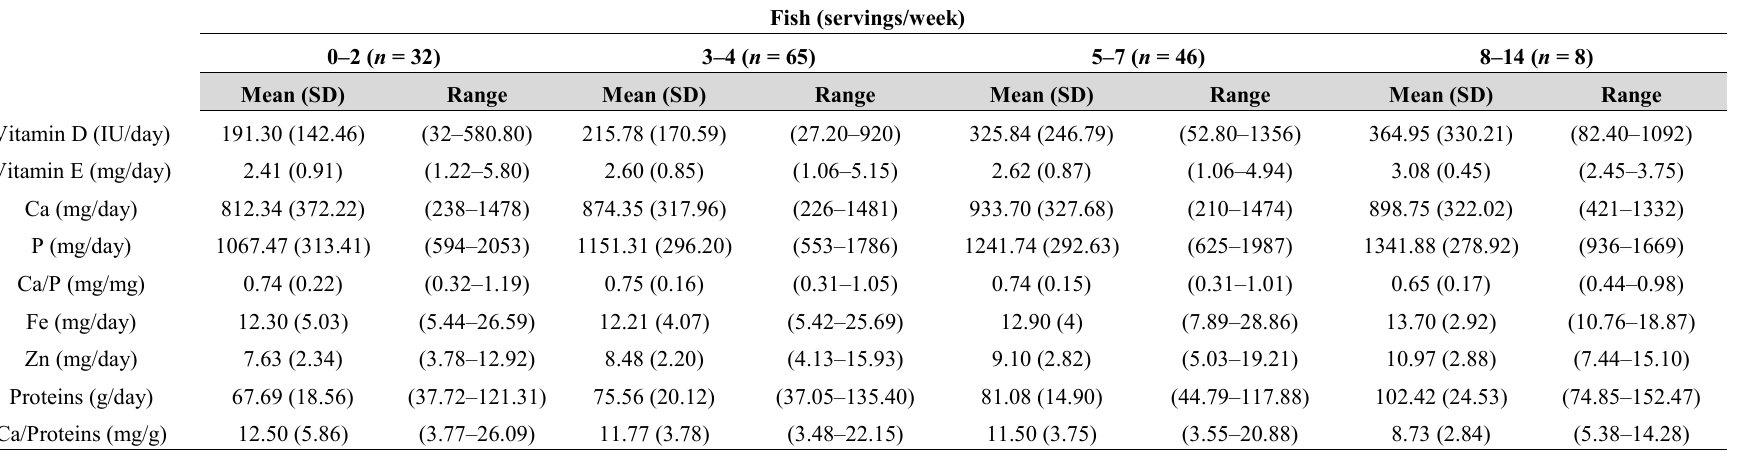
Table 3. Nutrient intake, distributed by fish consumption in premenopausal Spanish